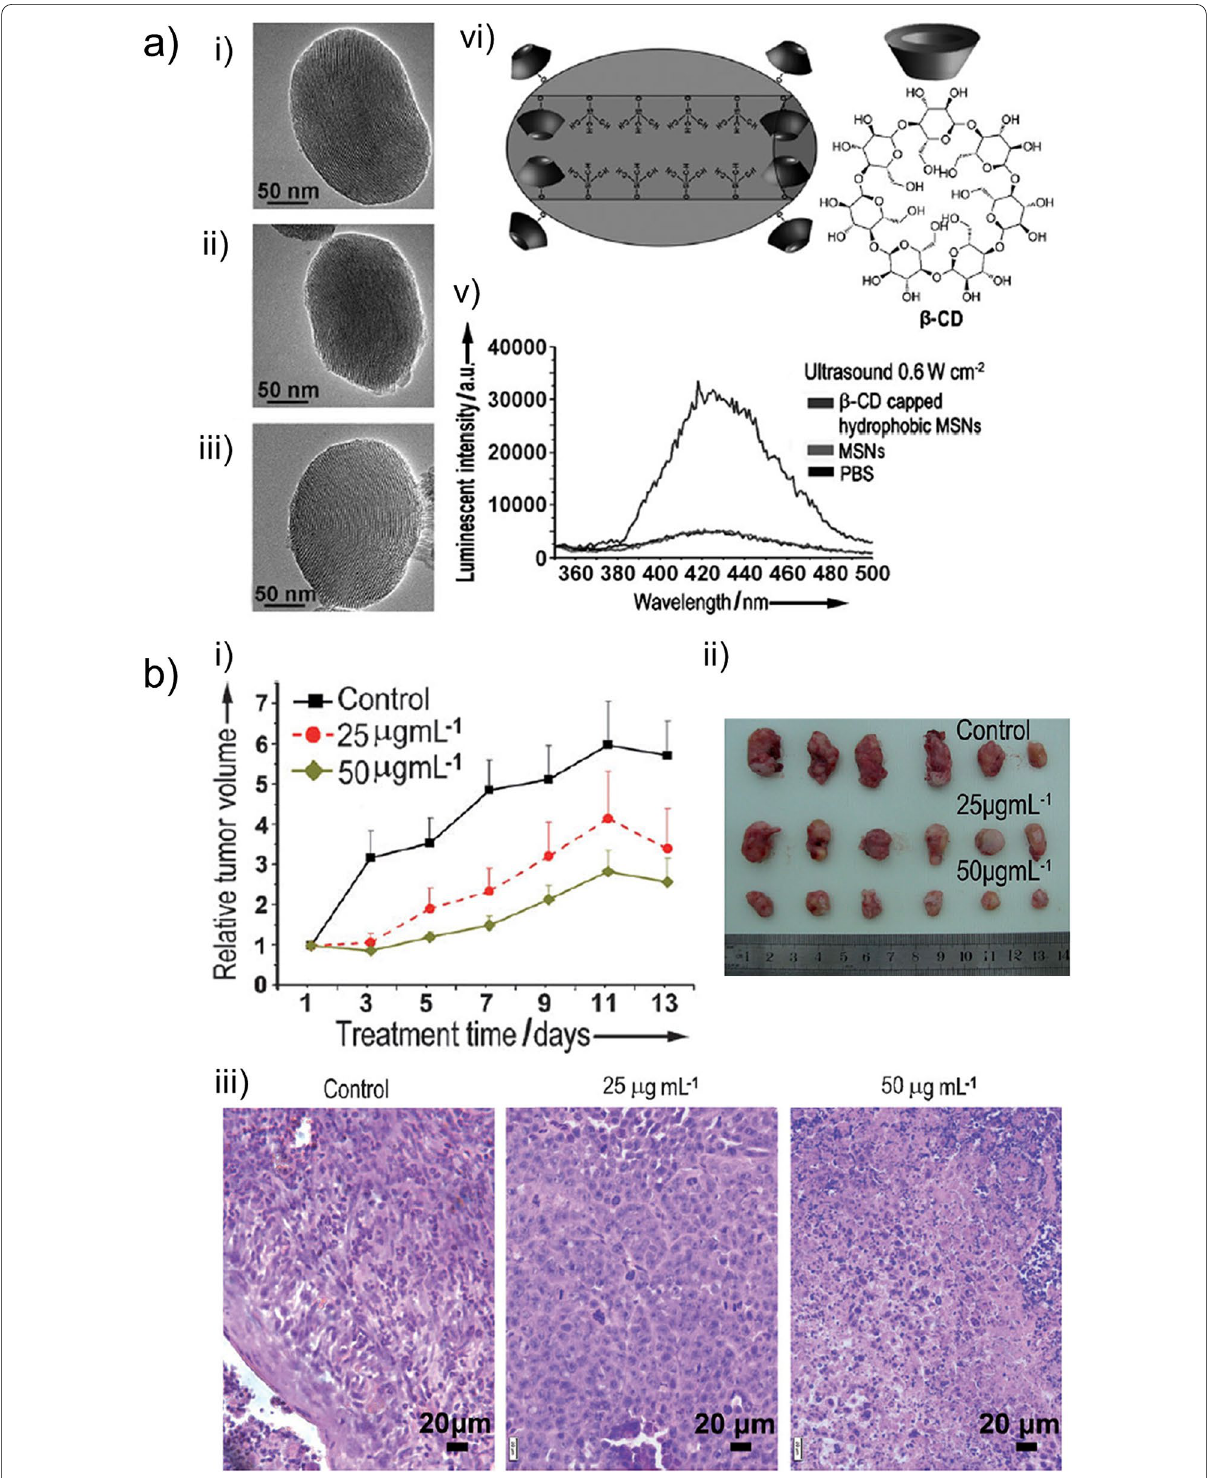
Fig.12 a TEM images of MSNs (i), hydrophobically modified MSNs (ii), and β-CD stabilized hydrophobic MSNs (iii). Schematic showing the molecular structure of hydrophobically modified MSN pore walls and β-CD (iv). Fluorescence assay showing in vitro ROS generation by MSNs after ultrasound exposure (v). b In vivo sonodynamic therapy using β-CD stabilized hydrophobic MSNs in ZR75-30 tumor model in mice. Relative tumor volumes of mice untreated or treated with ultrasound in the presence of nanoparticles at different concentrations (i). Photographs (ii) and H&E staining (iii) of tumors at end of the experiment. Adapted from reference [48], Copyright 2014, John Wiley and